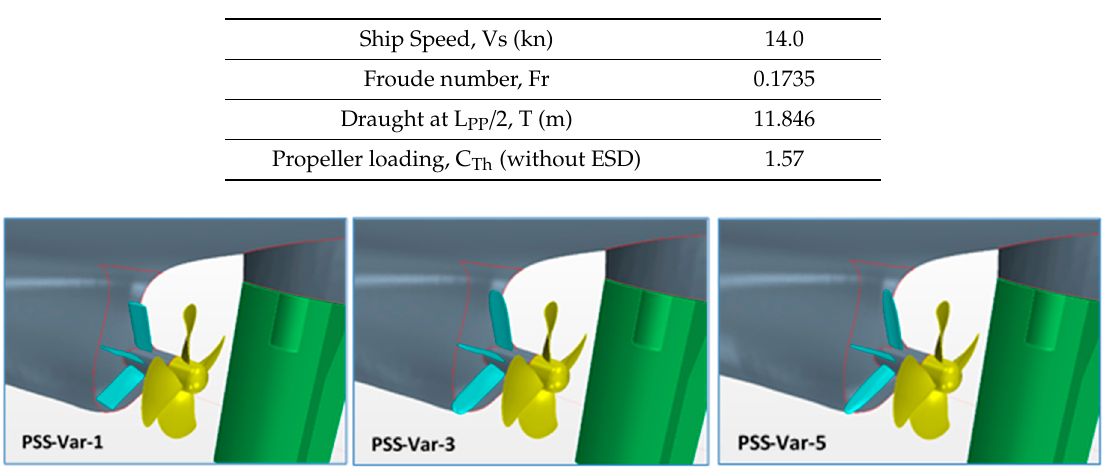
Table 3. Conditions for PSS design.